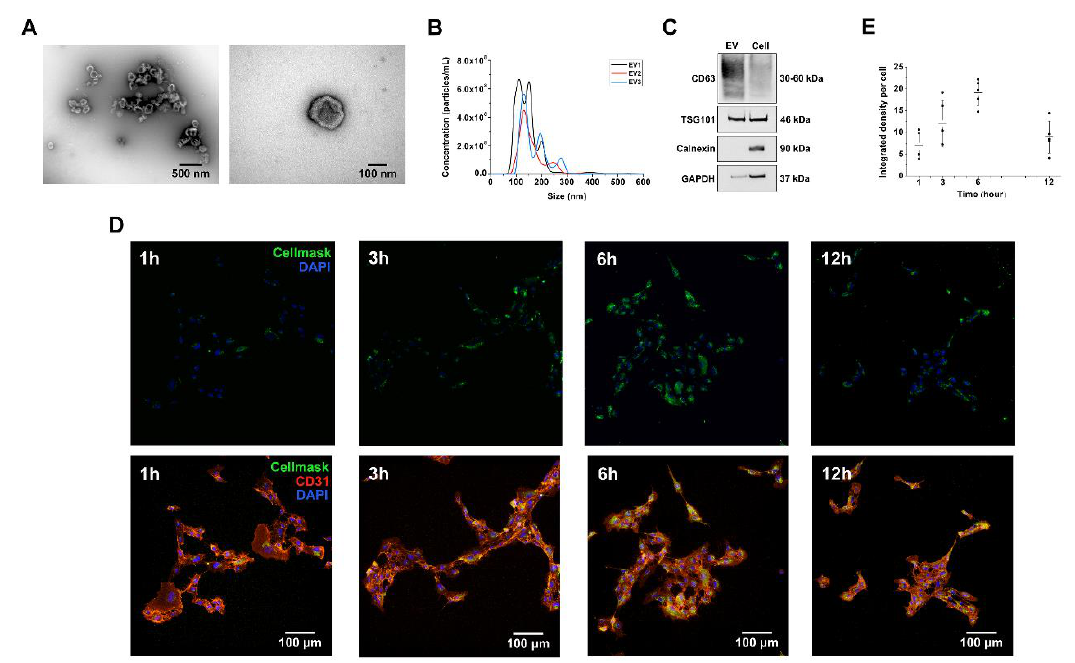
Figure 2. Characterization of DSPC-derived EVs. ( A ) Representative TEM images of EVs. ( B ) Size distribution of EVs was determined by nanoparticle tracking analysis (NTA), presented by three biological replicates (EV1–EV3) isolated from different DPSC cell lines. ( C ) The surface markers of EVs were analyzed by western blotting. ( D ) The uptake of CellMask Green-labeled EVs by HUVECs (stained with CD31) was visualized after 1, 3, 6 and 12 h of incubation, showing a time-dependent course. ( E ) The uptake of EVs was quantified as integrated fluorescent density signal per cell. The number of internalized EVs reached the maximum at 6 h.